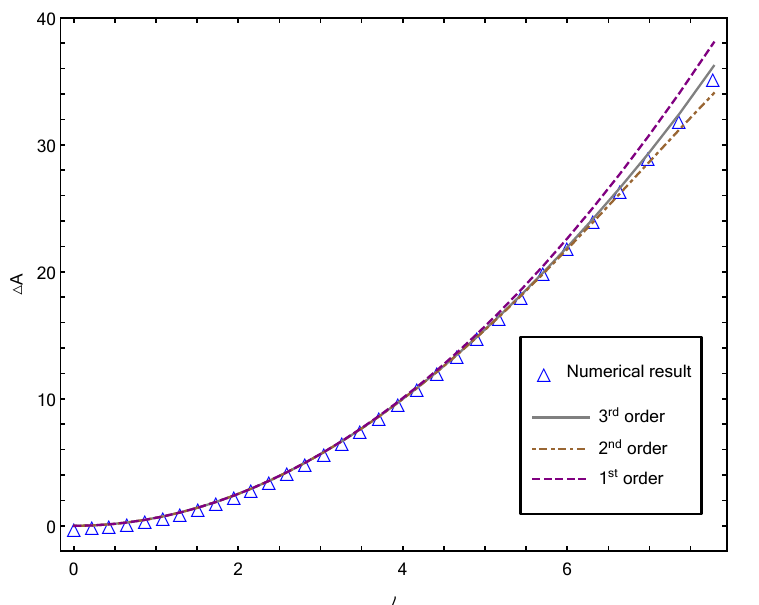
Figure 1. Area difference of the minimal surface from ground state at different orders for AdS 5 and their comparison with numerical result, plot drawn by choosing β = 0 . 25 and z h = 10